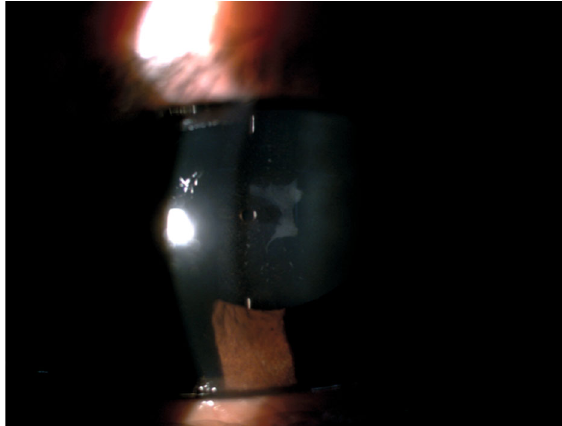
Figure 3: Anterior subcapsular cataract after TASS